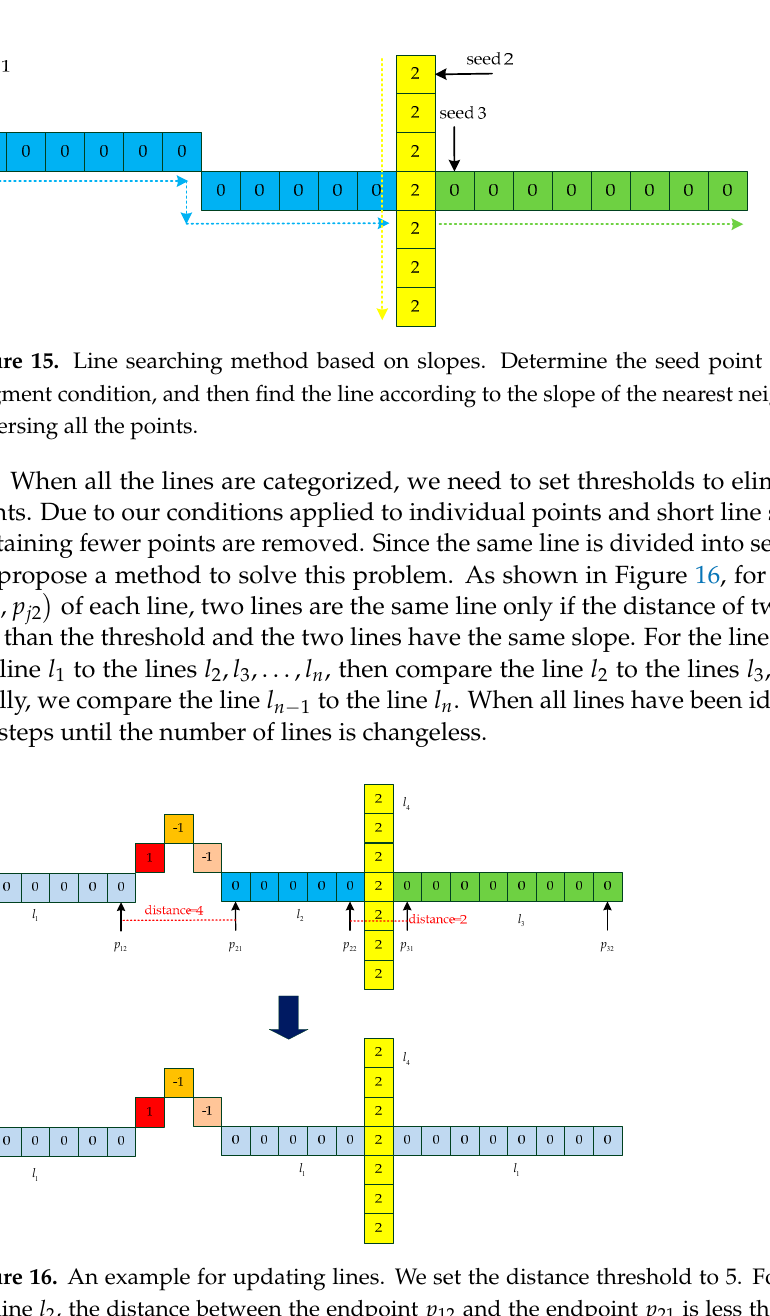
figure out their slopes and endpoints to update the lines. The principle of updating the endpoints is shown in Figure 17. We know the parameter of the line